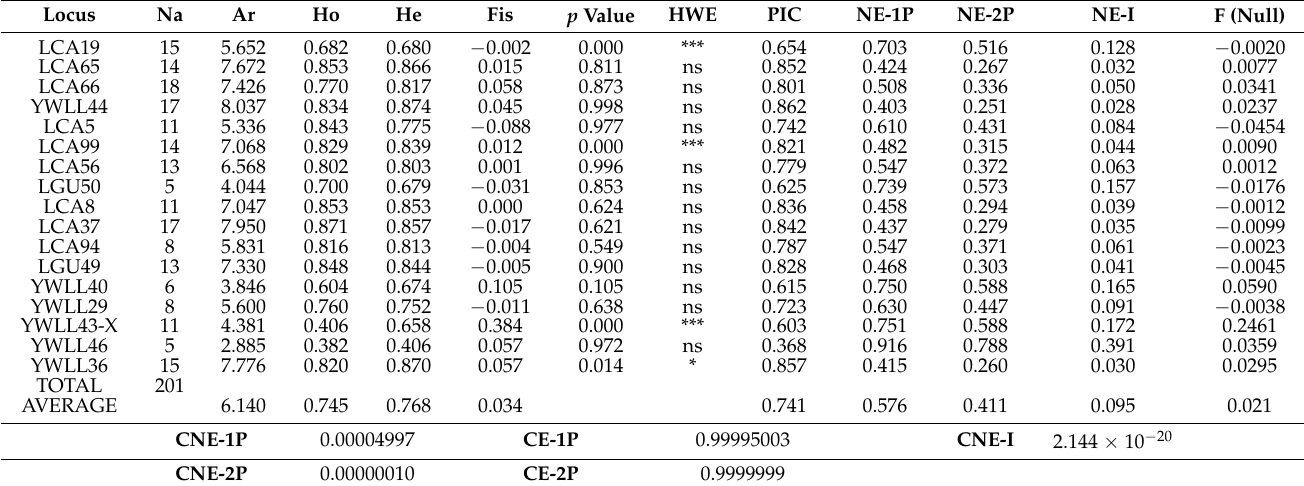
Table 5. Genetic diversity indices across 17 microsatellite markers used in this